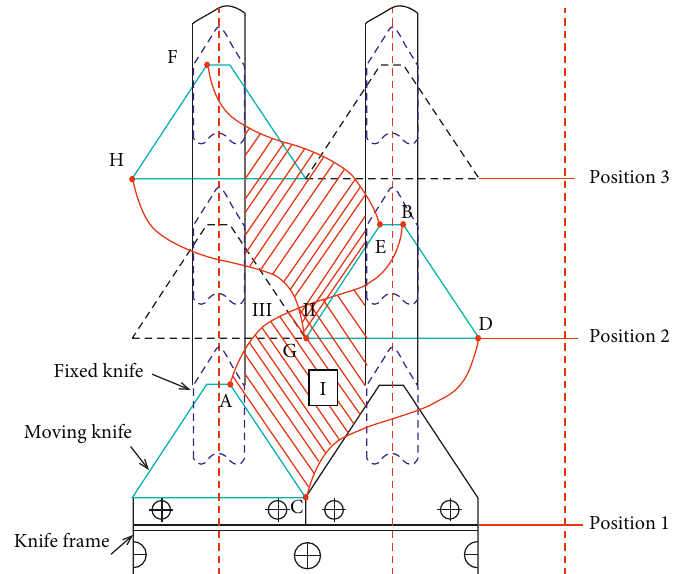
Figure 8: Cutting diagram of the movable knife.